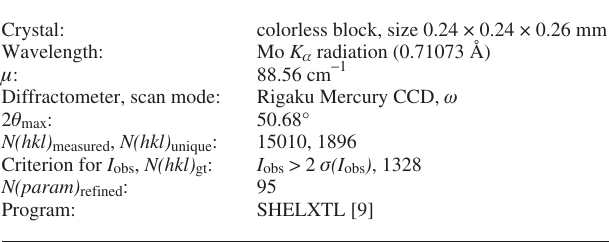
Table 1. Data collection and handling.